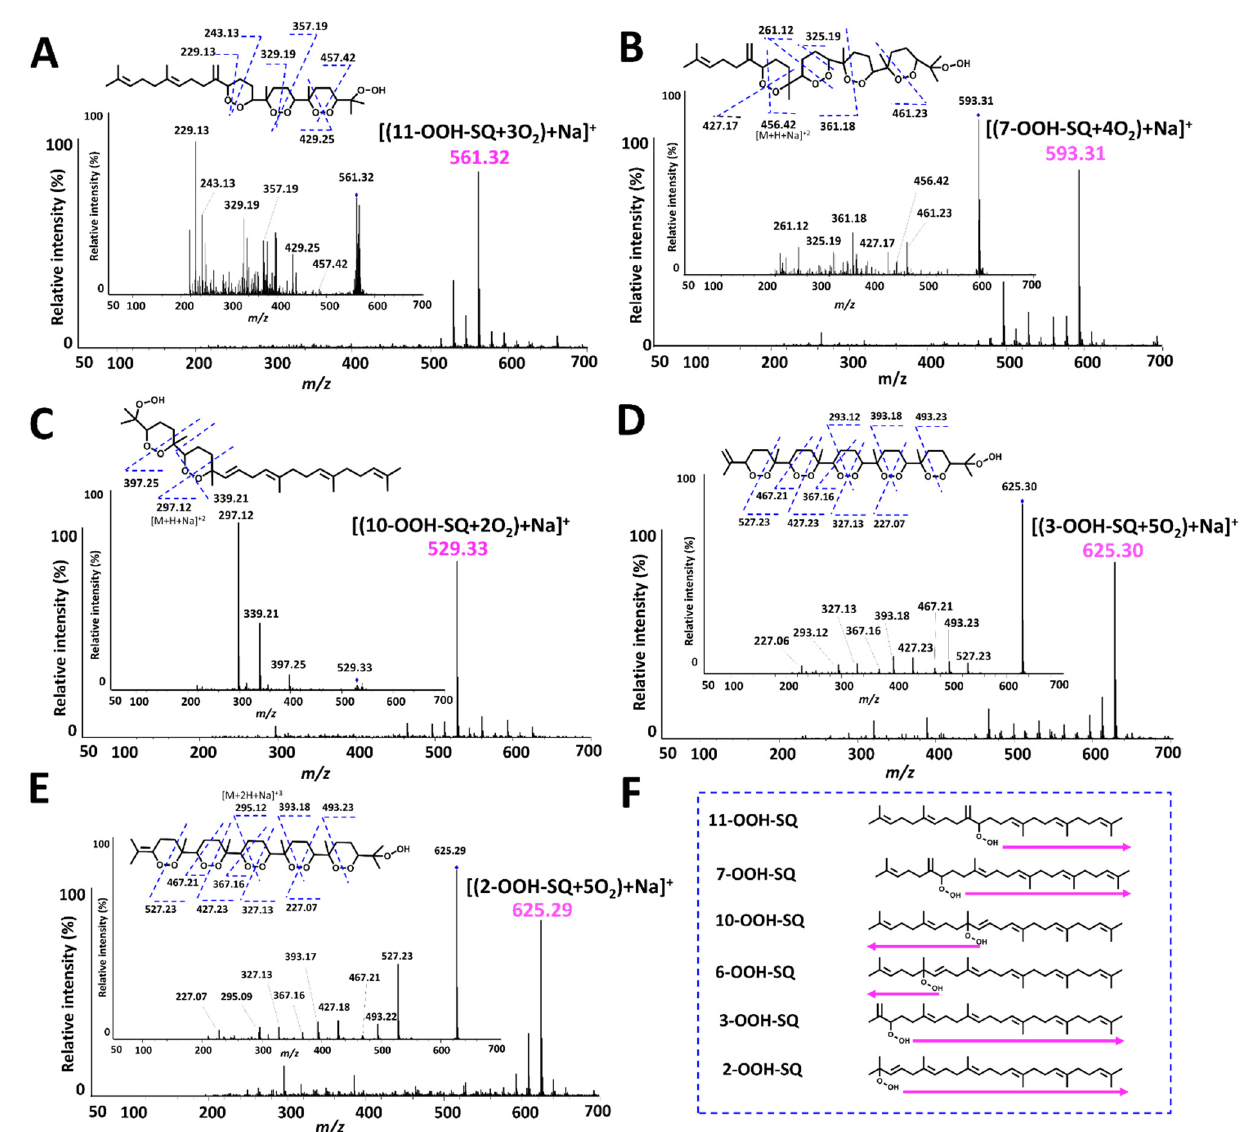
Figure 7. Q1 and PIS spectra of the main photooxidation products of individual SQ-OOH isomers and their suggested chemical structures. ( A ) [(11-OOH-SQ + 3O 2 ) +Na] + ; ( B ) [(7-OOH-SQ + 4O 2 ) +Na] + ; ( C ) [(10-OOH-SQ + 2O 2 ) +Na] + ; ( D ) [(3-OOH-SQ + 5O 2 ) +Na] + ; ( E ) [(2-OOH-SQ + 5O 2 ) +Na] + ; ( F ) direction of the chain reaction’s